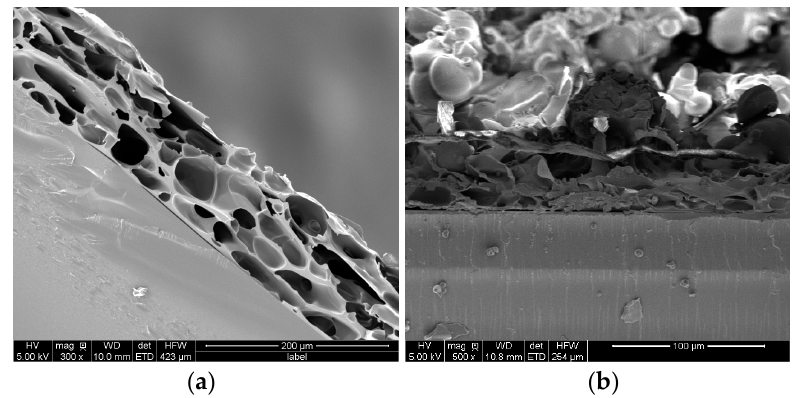
Figure 2. Cross-sectional structure of coatings fabricated using 5% PAA ( a ) and 8% PAA ( b ).